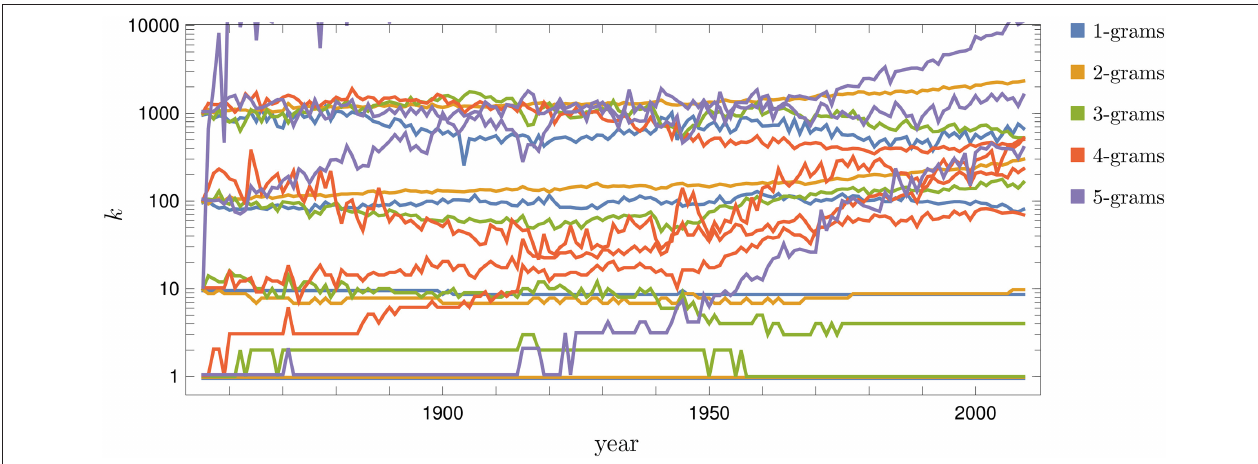
FIGURE 1 | Rank evolution of N -grams in French. Rank trajectories across time for N -grams ( N 1, ... ,5) that are initially in rank 1, 10, 100, and 1,000 at the year = 1855. The plot is semilogarithmic, so similar changes across ranks correspond to changes proportional to the rank itself. Other languages (not shown) behave in a similar way: changes are more frequent as N increases. We have added a small shift over the y -axis for some curves, to see more clearly how the most frequently used N -grams remain at k 1 for long periods of =